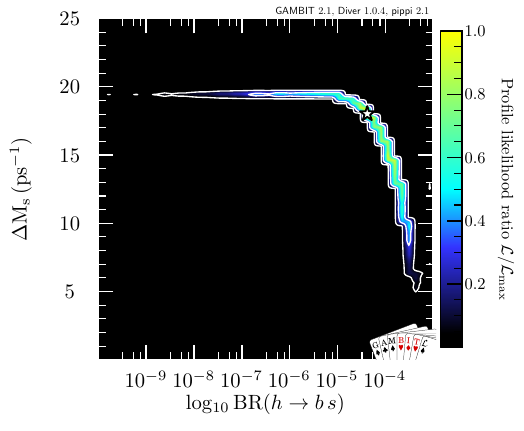
Figure 17 . Profile likelihood contours in the ∆ M s - BR( h → b s ) plane obtained with a scan using s βα ∈ [0 . 9999 , 1] . The observed correlation is expected from eq. (4.18) in [71].